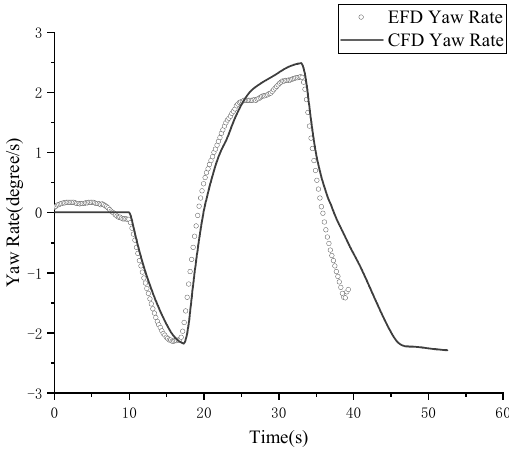
Figure 26. Yaw rate in − 10 ◦ zigzag maneuver.